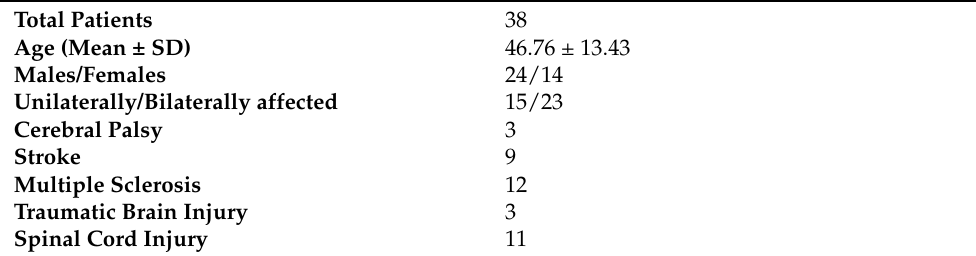
Table 1. Patient database description.